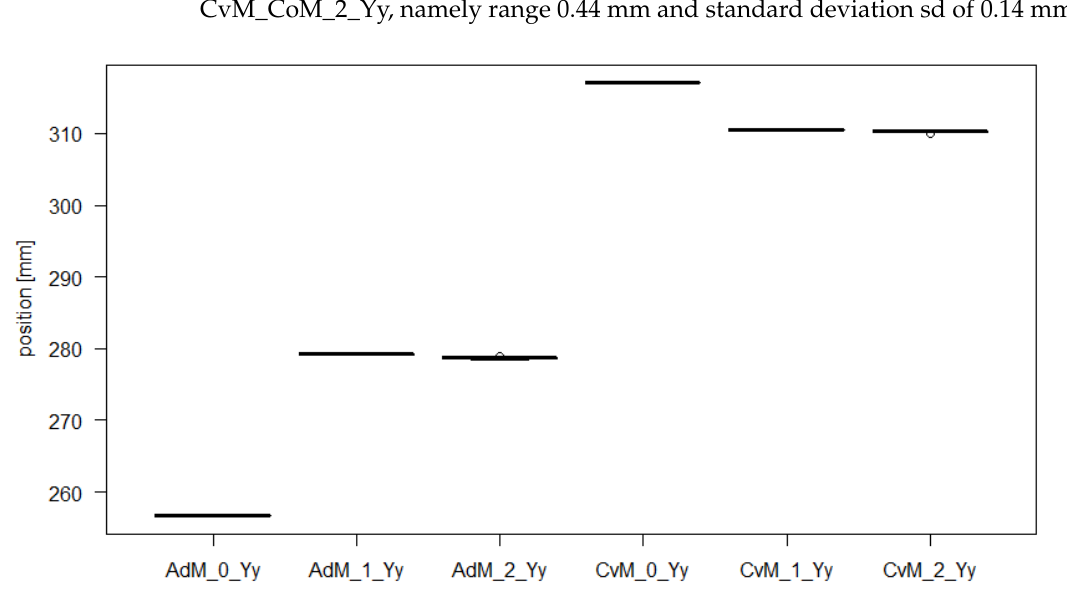
Figure 14. Measurements of CoM axis Y.